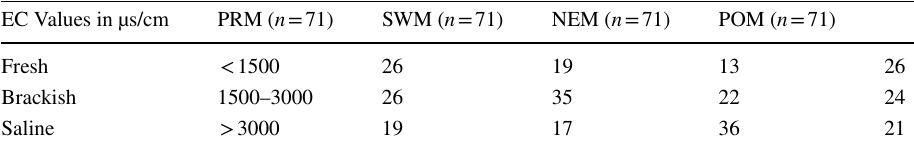
Table 3 Samples distributed in different categories of Electrical conductivity with respect to